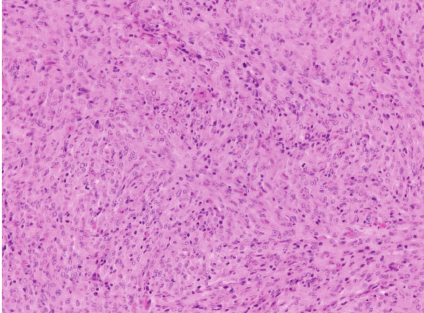
Figure 3: Histological analysis showed a multinodular infiltration throughout the spleen by atypical mesenchymal